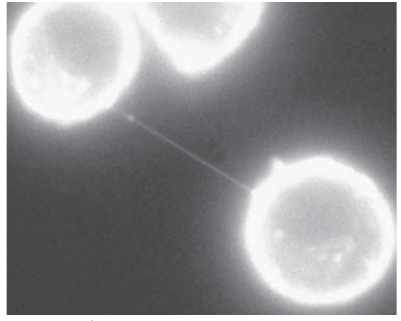
Figure 1. A TNT Connecting Two Neighbouring Cells Immunofl uorescence analysis of wheat germ agglutinin–stained PC12 cells that shows a TNT, a novel type of cell protrusion that establishes membrane continuity between two neighbouring cells. Transfer of molecules and organelles can occur directly from the cytoplasm of one cell to that of the other. (Image courtesy of Hans-Hermann